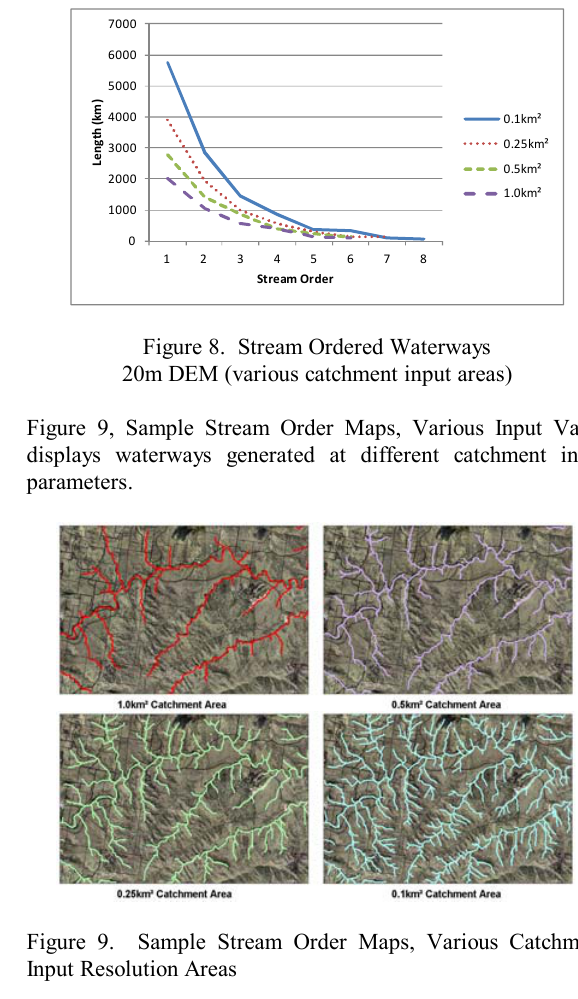
Table 2. Data derived from sample area of available DEMs (See Figure 1 – Detailed DEM Assessment Area).